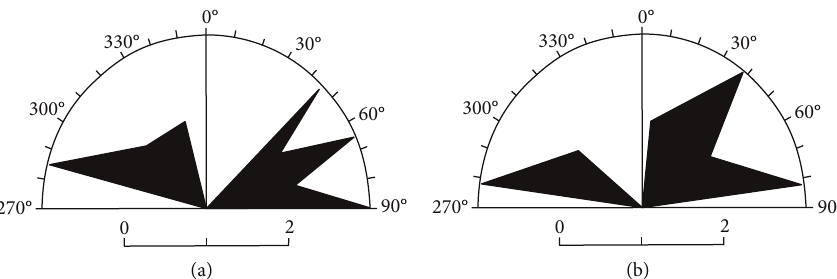
Figure 5: Relationship between the orientation of principal stress and vertical fractures in Sihe mine: (a) maximum principal stress direction; (b) vertical fracture